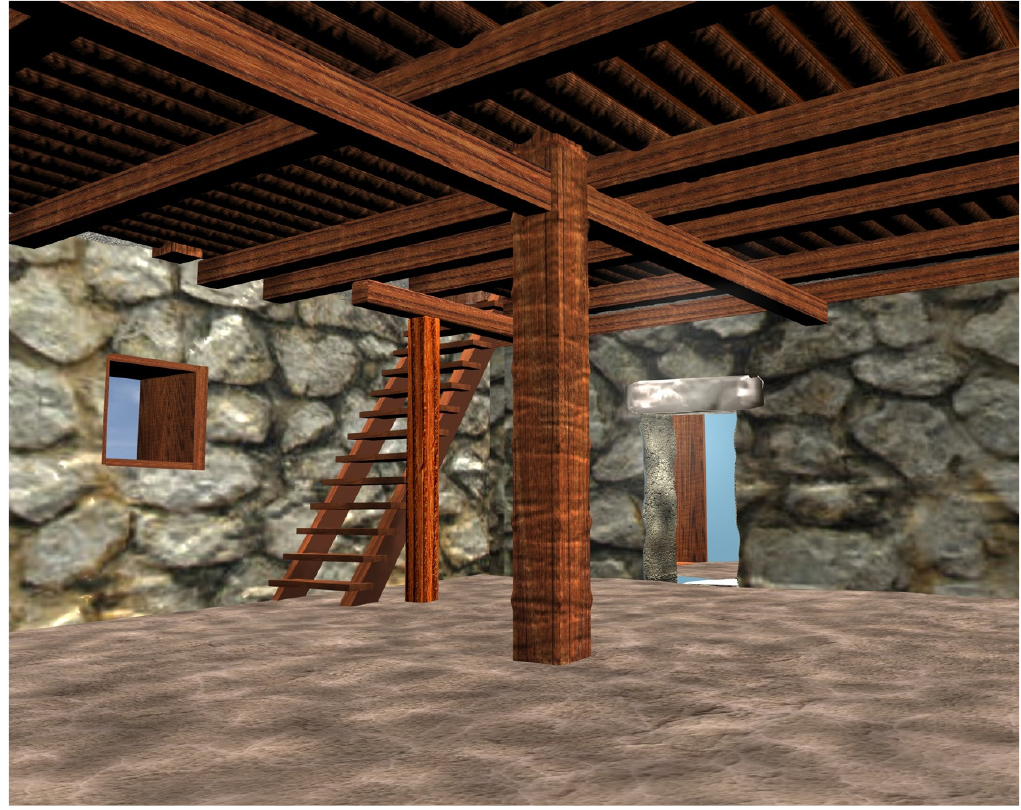
Figure 5. The interior of Building I. All interior details are conjectural. Created in Cinema 4D.